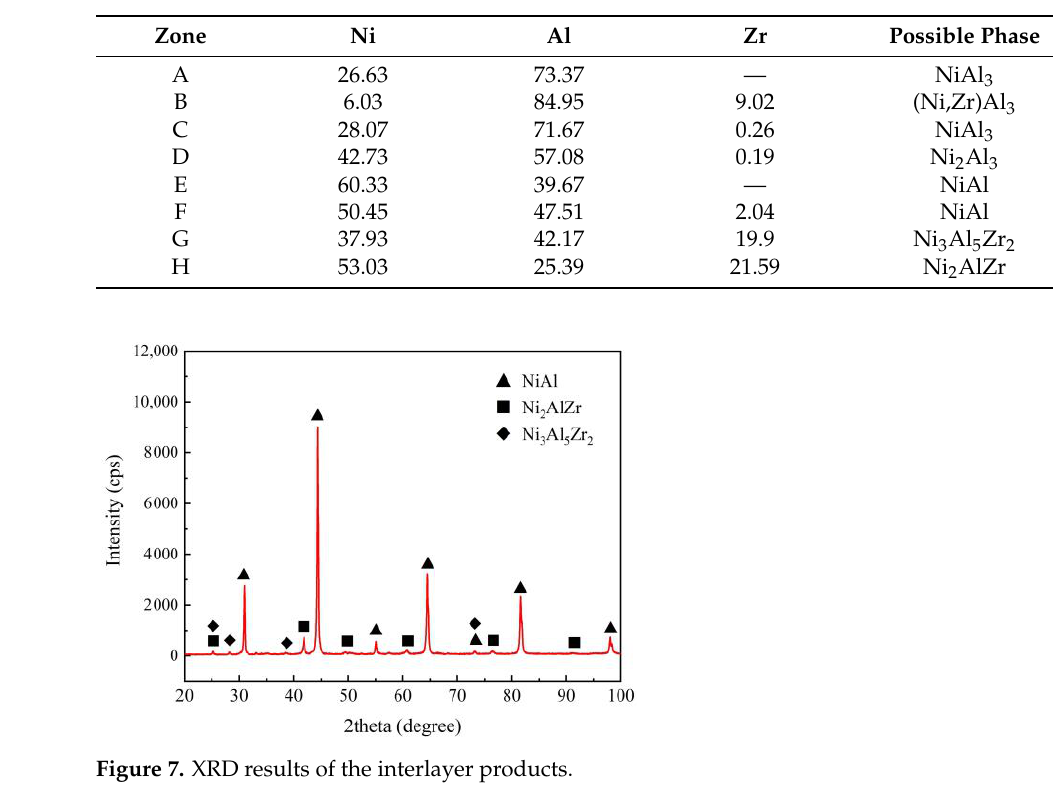
Table 1. EDS results on zones in Figure 6 (at.%).